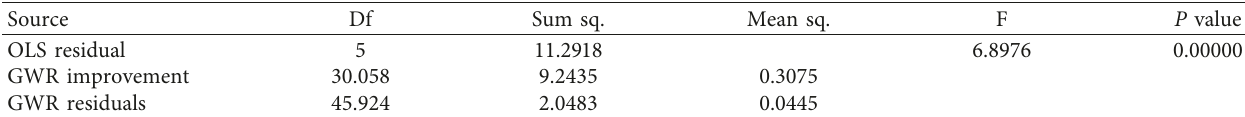
Table 4: Analysis of variance for goodness-of-fit of the GWR model.